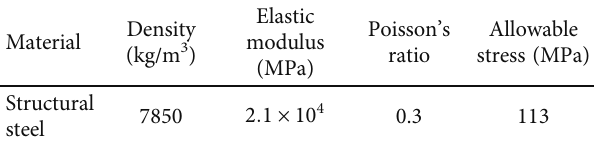
Table 2: Main parameters of structural